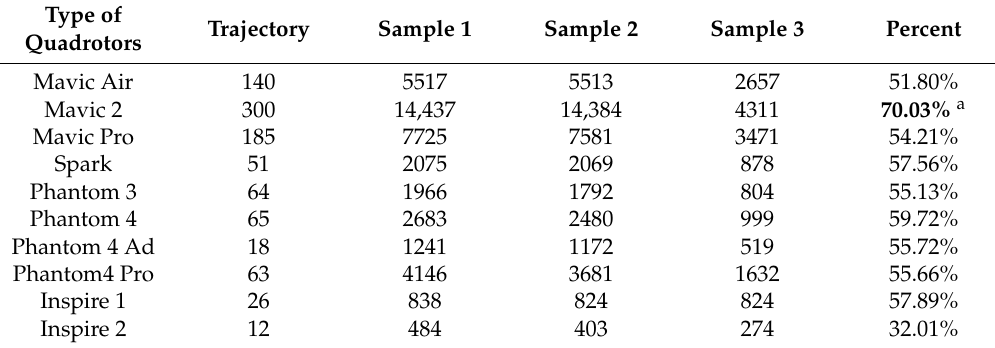
Table 2. Number of trajectories for each kind of quadrotor.